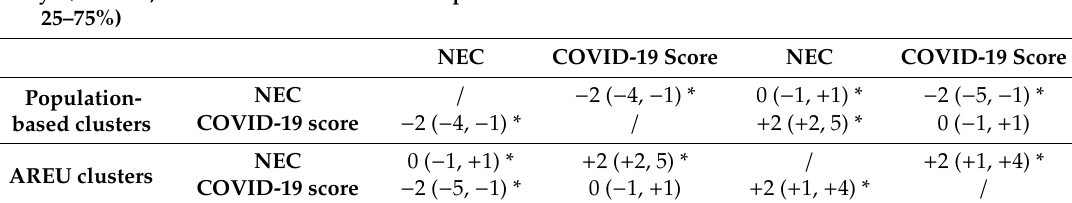
Table 1. Matrix of comparison of the di ff erence in the identification of the starting day t (beginning of the exponential growth of the curve) by using normalized emergency calls (NEC) or ambulances-based COVID-19 score, and applying di ff erent clustering definition of municipalities (population-based